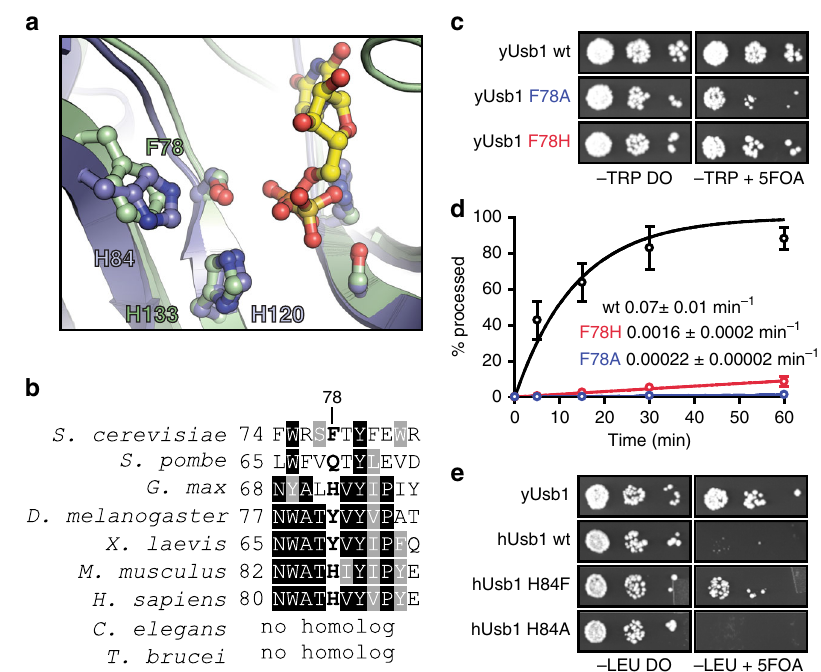
Fig. 3 Residue F78 in fl uences RNA processing by yUsb1. a Overlay of yUsb1 and hUsb1 active sites shows that yUsb1-F78 and hUsb1-H84 are positioned similarly adjacent to the active site. b Sequence alignment of the region surrounding yUsb1-F78/hUsb1-H84. Several residues (yUsb1 W75 and Y80) are perfectly or near-perfectly conserved, while conservation of position F78 is limited to aromaticity. c Usb1 mutants F78A and F78H can complement genomic deletion of USB1 using plasmid shuf fl e and assaying for growth on media containing 5- fl uoroorotic acid (5-FOA). Usb1-F78A results in a growth defect. d Quanti fi cation of the rate of Usb1 processing on a fl uorescent substrate (as in Fig. 1) with different substitutions at position 78. Plotted data points represent the average of three technical replicates ± s.d. e Overexpression of yUsb1 (under control of the GPD promoter) complements deletion of USB1 , but overexpression of hUsb1 results in an extreme slow growth phenotype. Overexpression of hUsb1-H84F partially rescues growth, while hUsb1-H84A does